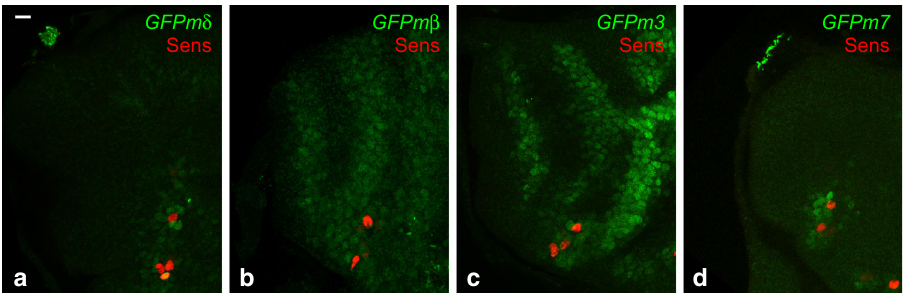
Fig. 4 m3 and m β are expressed early in response to the bimodal gradient of Dl. GFPm δ ( a ) GFPm β ( b ), GFPm3 ( c ), and GFPm7 ( d ) reporters (GFP, green) are detected at 2.5 h apf. GFPm β is expressed in stripes like GFPm3. GFPm δ , and GFPm7 are weakly expressed in the non-selected cells from the DC proneural cluster. Sens (red) marked sensory cells of the future DC macrochaetae, used here as a landmark position for the future proneural stripe 5. Scale bar is 10 μ m ( a : a – d